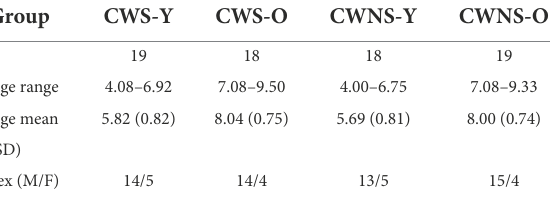
TABLE 1 Demographic characteristics of the participants in the 4 subgroups (children who stutter-younger and older = 37; children who do not stutter-younger and older =